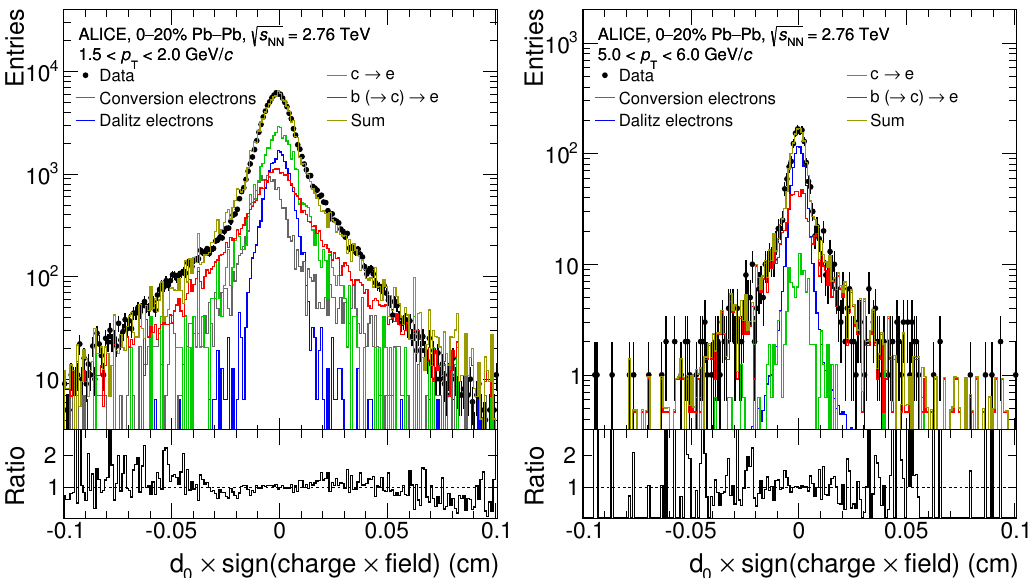
Figure 1 . Impact parameter distribution for the interval (left) 1 : 5 < p T < 2 : 0 GeV =c and (right) 5 < p T < 6 GeV =c in the 20% most central Pb-Pb collisions. The impact parameter value of each track was multiplied by the sign of the charge of each track and the sign of the magnetic (cid:12)eld. The individual distributions for electrons from beauty-hadron and charm-hadron decays, from Dalitz-decays of light mesons, and from photon conversions were obtained by HIJING and PYTHIA simulations. The bottom panel shows the ratio of the data and